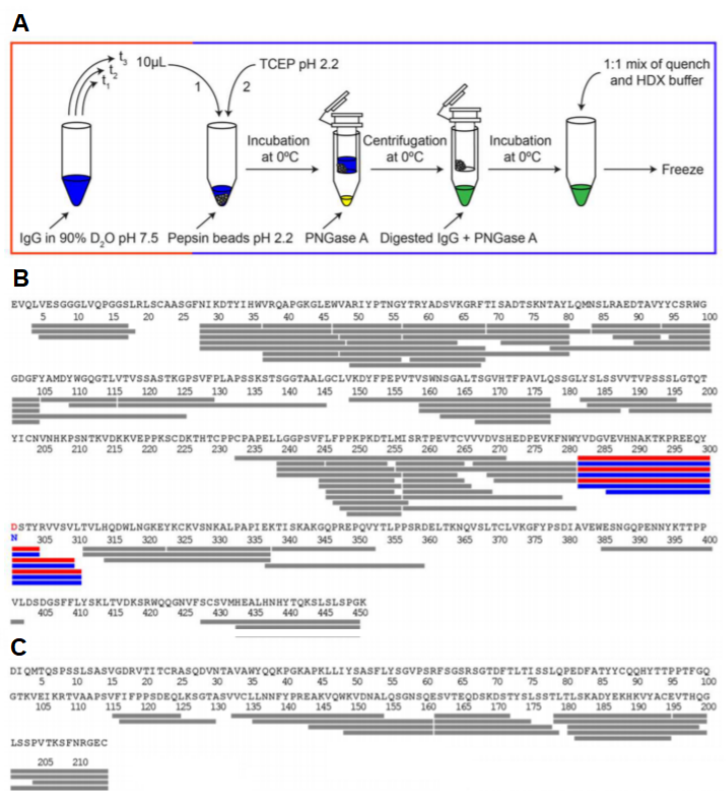
Figure 12. ( A ) HDX-MS workflow with in-solution deglycosylation at low pH using PNGase. HDX-MS sequence coverage of Trastuzumab ( B ) heavy chain and ( C ) light chain using the optimized workflow. The glycosylated residue N301 and the deamidated deglycosylated residue D301 are